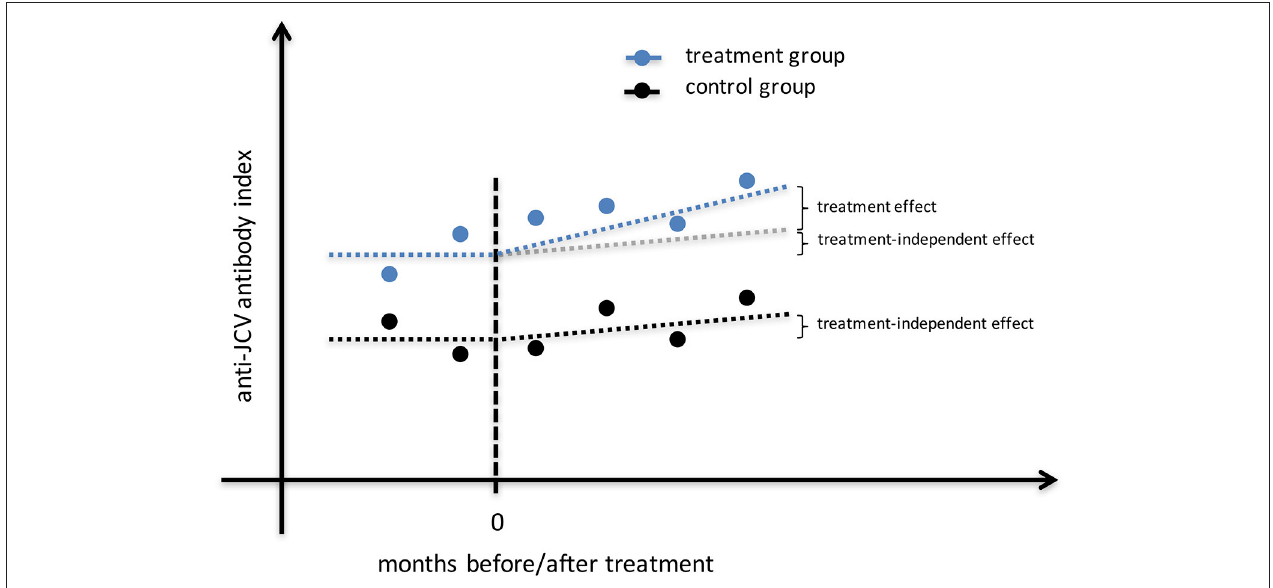
FIGURE 1 | Study design for identification of treatment effect on anti-JCV antibody index. The illustrated estimation approach shows anti-JCV AI evolution for the no DMT group that may change (e.g., increase) over time, as well as anti-JCV AI evolution for a treatment group that may change (e.g., increase) due to the same effect as in the no DMT group plus a possible treatment effect. To correctly estimate the treatment effect, a mixed model is employed that considers any effect that appears also in the no DMT group independent of the applied treatment. Therefore, several samples before and after start of treatment per patient are required. AI, antibody index; DMT, disease modifying treatment; JCV, John Cunningham virus. TABLE 1 | Demographic and clinical characteristics of the study cohort.